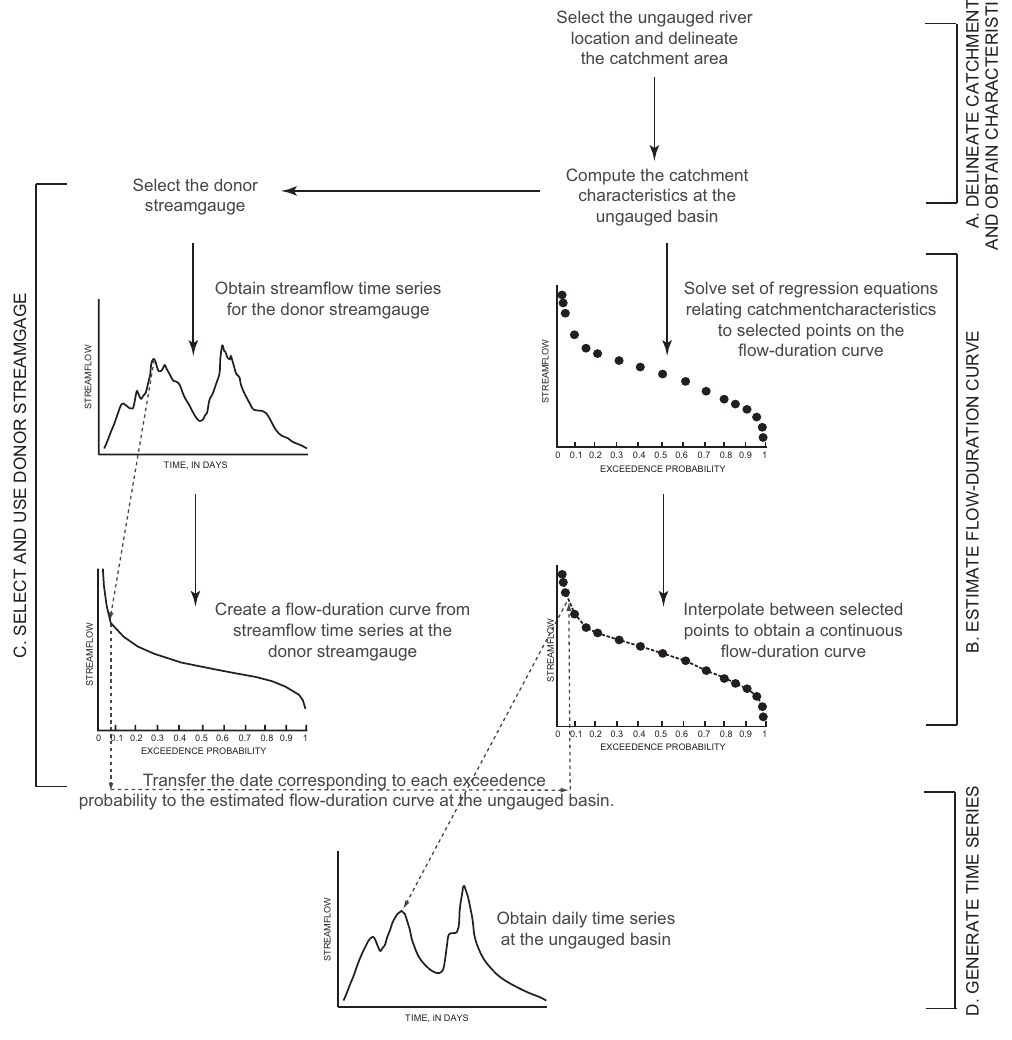
Fig. 1. Diagram of the process to estimate unregulated, daily streamflow at ungauged locations. An ungauged river location is selected, and the catchment characteristics are computed (A) . The flow-duration curve is then estimated using regression relations between the catchment characteristics and selected points on the flow-duration curve (B) . A donor streamgauge is then selected (C) and used to transfer the estimated flow-duration curve into a time series of daily streamflow at the ungauged location (D) .